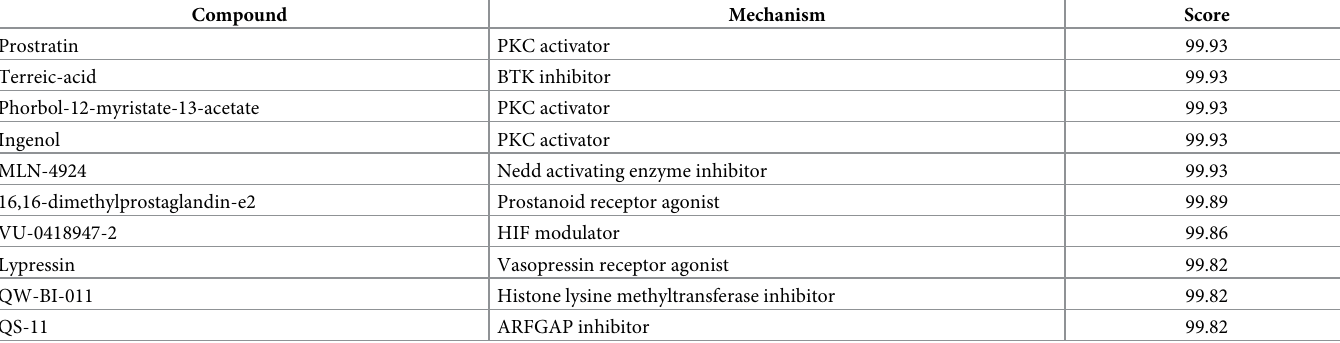
Table 3. Module-based drug repurposing output reveals several potential drug candidates for aneurysm rupture. Top 10 compounds by score (a metric of how well the drug-disease signatures match) and their mechanisms are listed, with PKC activators, BTK inhibitor, and Nedd activating enzyme inhibitor being the highest ranked